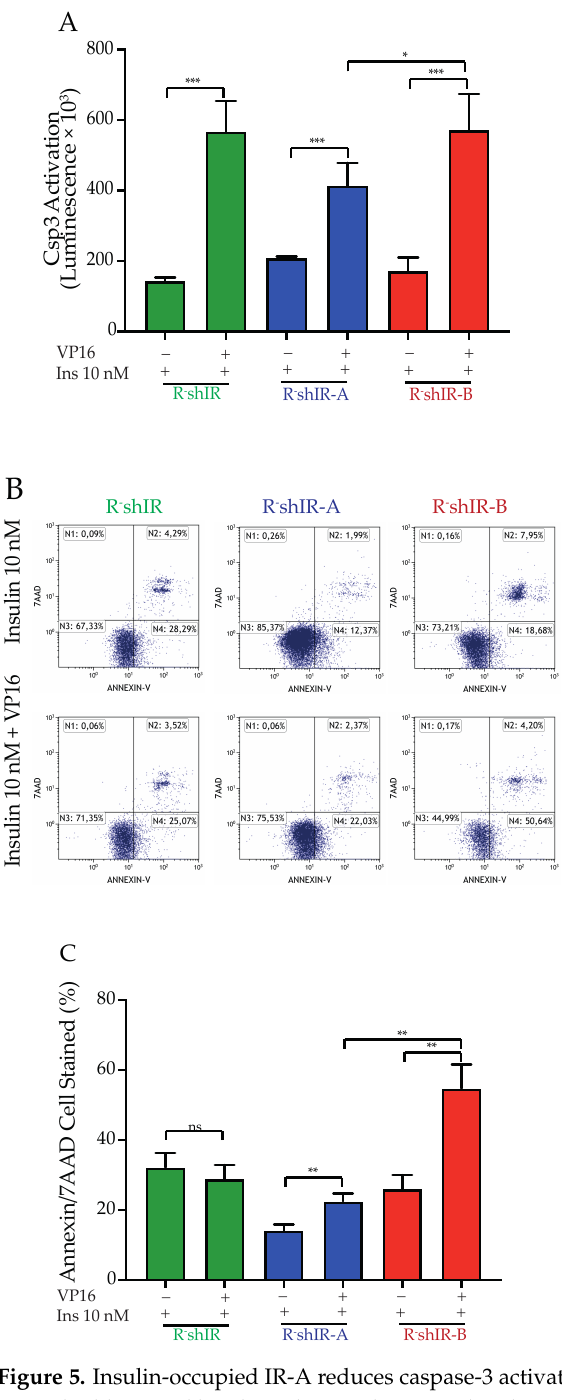
Figure 5. Insulin-occupied IR-A reduces caspase-3 activation and protects cells from apoptosis after DNA double-strand break. R-shIR, R-shIR-A and R-shIR-B cells, exposed to doxycycline 1 µ g/mL for 72 h, were grown in DMEM supplemented with bovine serum albumin 0.1% and 2 mM glutamine and exposed or not to VP-16 in the presence of 10 nM insulin for 24 h. ( A ): caspase-3 activation; histograms represent the average of the luminescence value of cleaved caspase-3 and the bars indicate standard deviation obtained from three independent experiments. ( B ): Cell staining (Annexin A5 FITC/7-AAD, Beckman Coulter Kit) was performed with cytofluorometric analysis employing Cytomics FC500. ( C ): Average values of Annexin V and 7-AAD-positive cells after exposure to only insulin or in the presence of both insulin and VP-16. Bars indicate the standard deviation from two independent experiments. The GraphPad Prism software was used to perform two-tailed t-test with 95% of confidence intervals (* p < 0.05, ** p < 0.01, *** p <